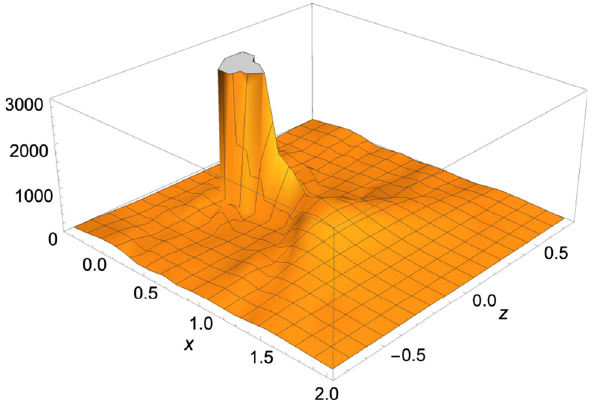
Fig. 2 Numerical integration of the integral in (29) with y = − 1 ,ε = 0 . 0001. The figure plots the values of | Ψ( x , z ) | 2 against x , z . Values over 3000 are chopped. For z we used a step of Δ z = 0 . 125 and for x a step of Δ x = 0 . 125. The function peaks around z = 0, which agrees with the expectation from the highlighting